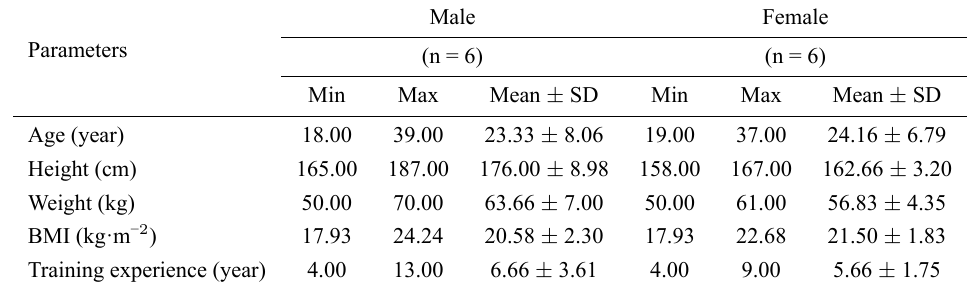
Table 1. Sports experience and demographic values of Para-badminton athletes (mean ± standard